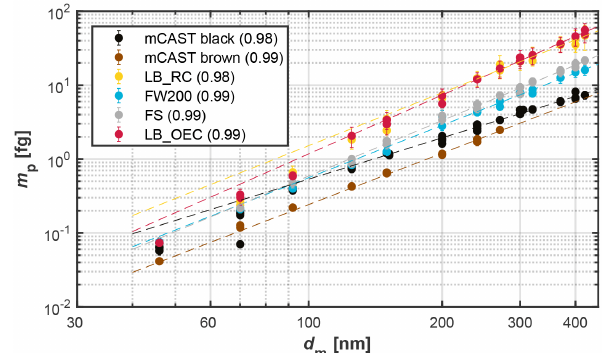
Figure 4. DMA–CPMA data for the different soot types: electrical mobility diameter ( d m ) vs. median particle mass ( m p ) derived from fitting the resulting mass distribution with a log-normal distribution. Error bars correspond to standard deviations of the individual mea- surements and dashed lines to the power law fits using Eq. (A4). The values in parentheses give the R 2 of the